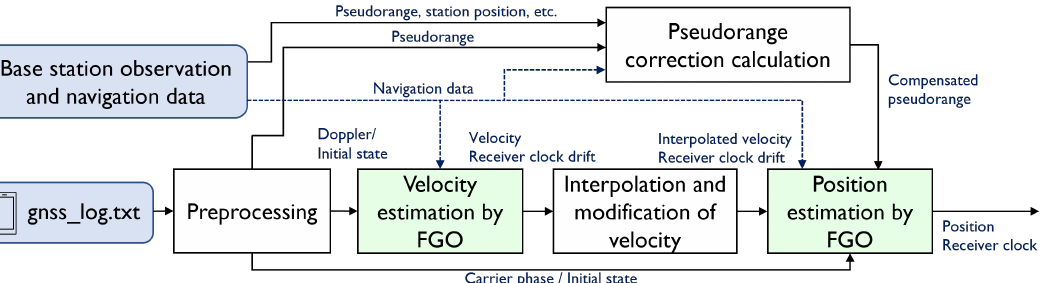
Figure 3. Flow of the proposed method comprising two optimization steps: velocity estimation and position estimation via factor graph optimization